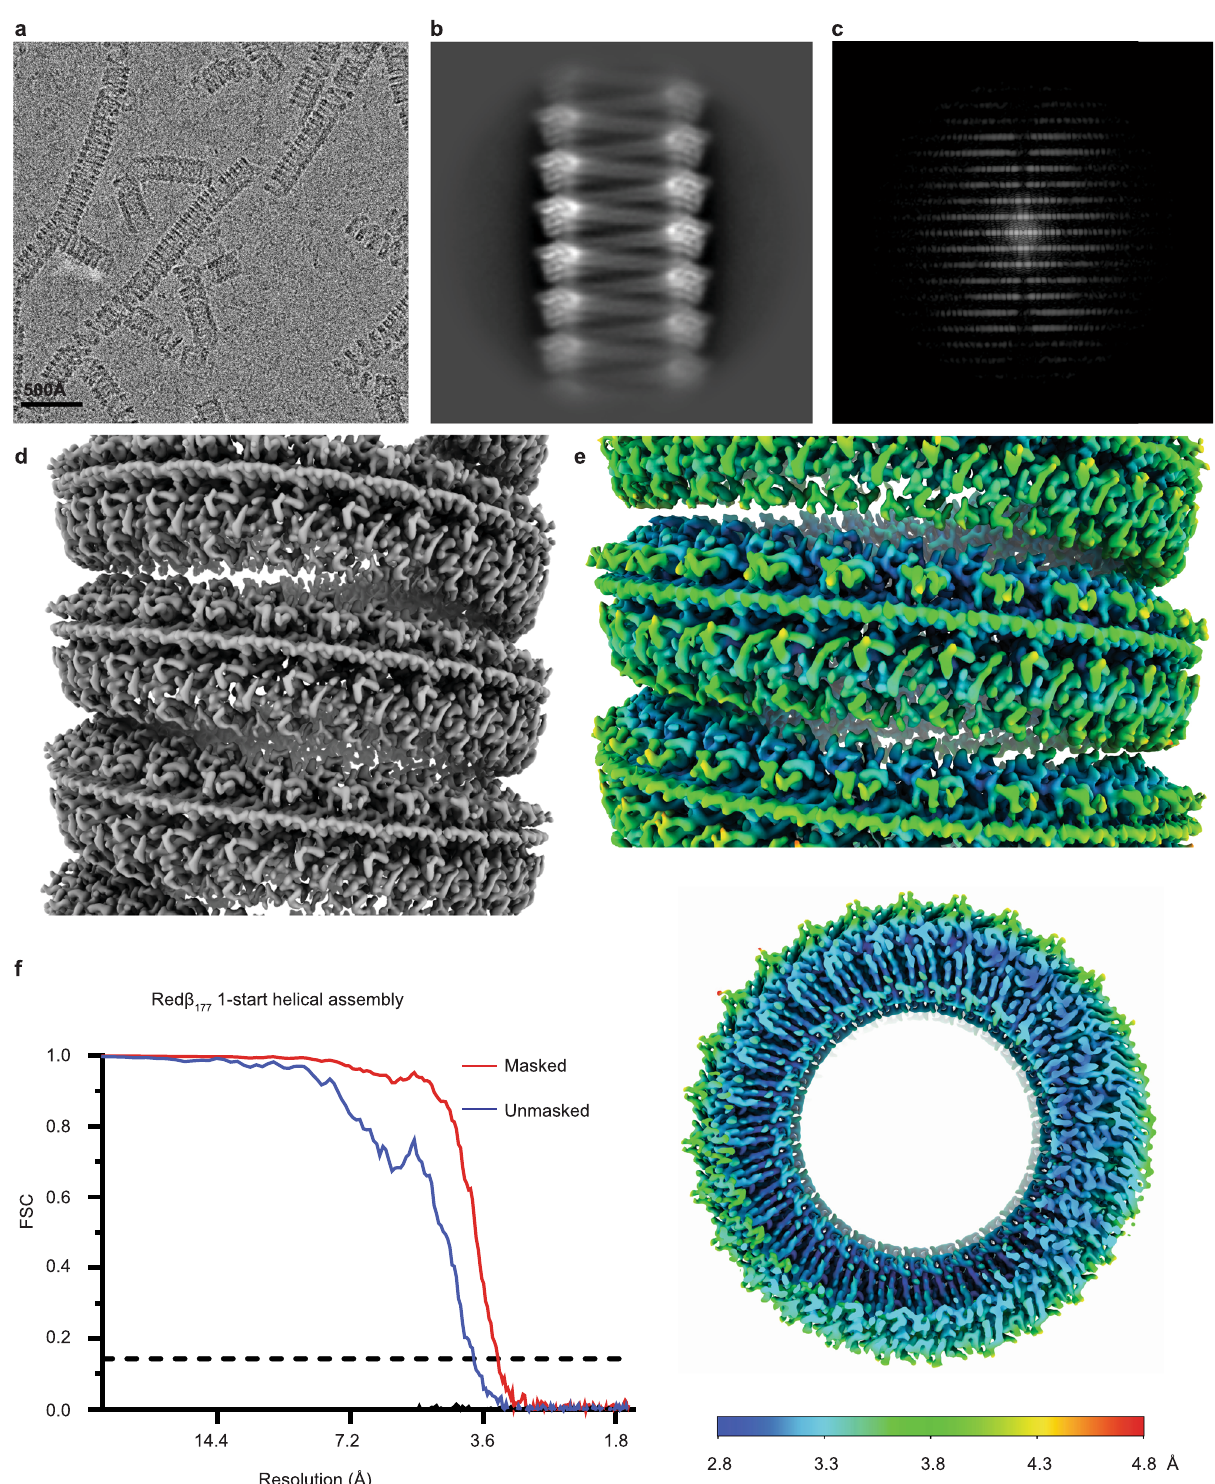
Fig. 1 | Cryo-EM structure ofRed β 177 1-start helical assembly, resolved to 3.3Å. a ArepresentativeelectronmicrographdisplayingRed β 177 helices.Amongthe4701 electron micrographs collected, all images identi fi ed as containing our protein sample displayed similar helical fi laments. b A representative 2D class average of the helical fi laments. c Fourier transform of a 2D class average. d Cryo-EM map of